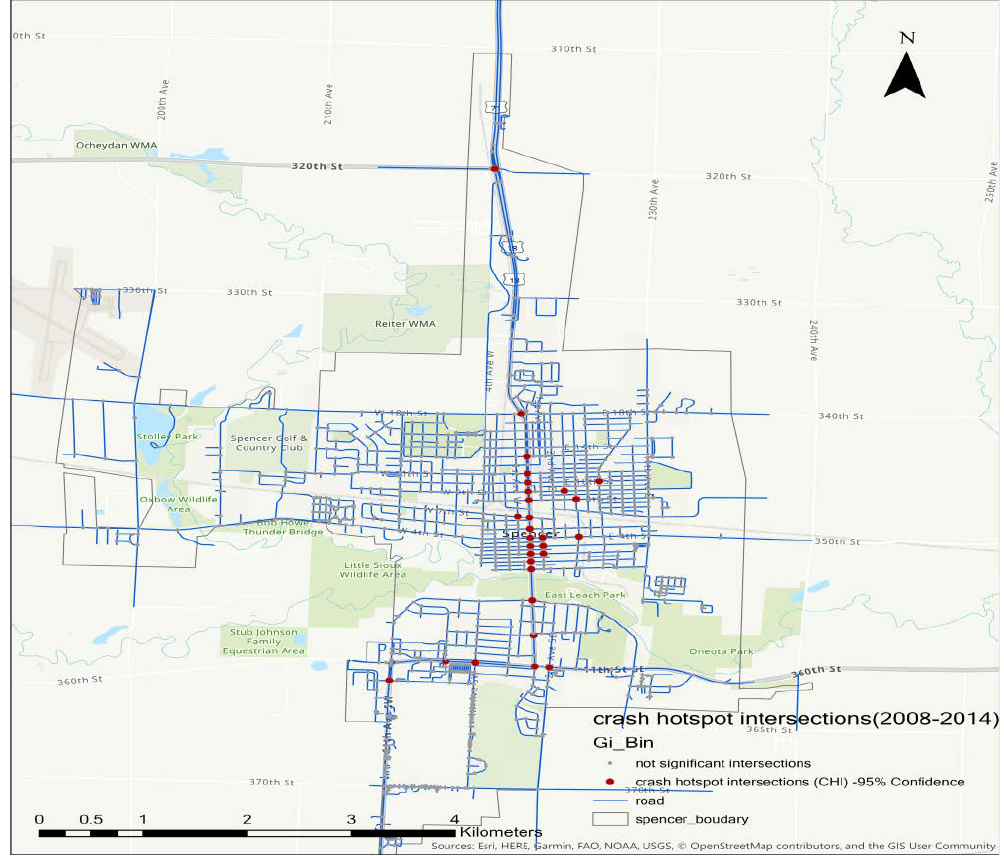
Figure 11. Distribution of crash hotspot intersections in Spencer city.